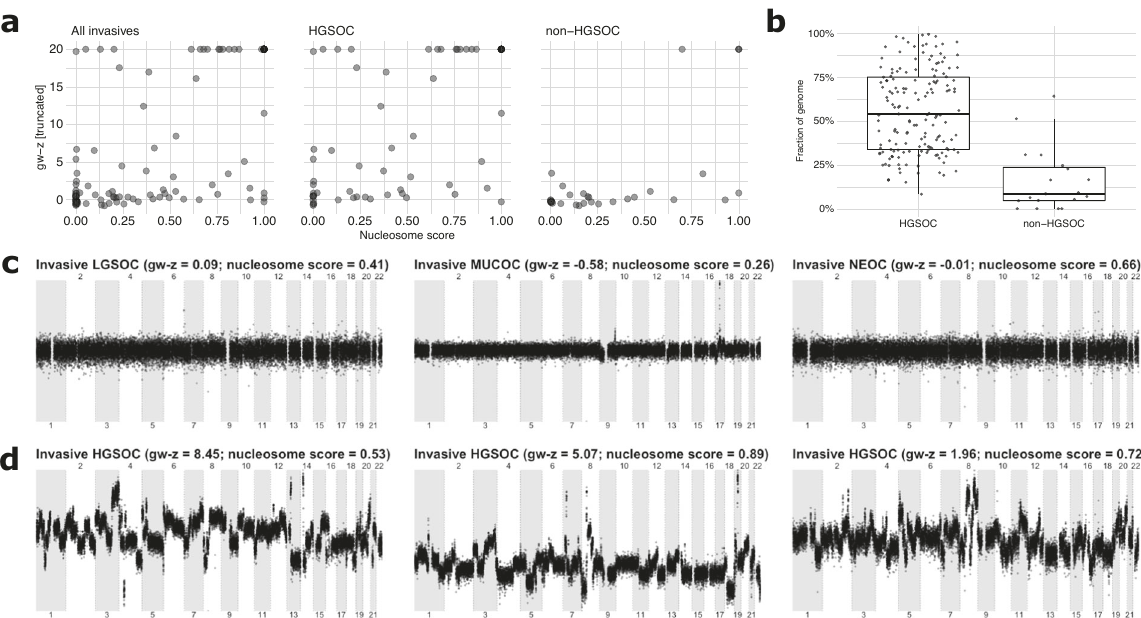
Fig. 4 Characteristics of non-HGSOC cases. a Correlation between nucleosome and genome-wide z -scores for all invasive tumor samples (including eight metastasis samples), HGSOC and non-HGSOC samples. b Fraction of the genome that is not copy-neutral for a HGSOC 30 and non-HGSOC cohort. c , d Illustrations of genomic representation pro fi les obtained from baseline fresh-frozen tumor tissue for three non- HGSOC samples (LGSOC, MUCOC, and NEOC) and for three HGSOC